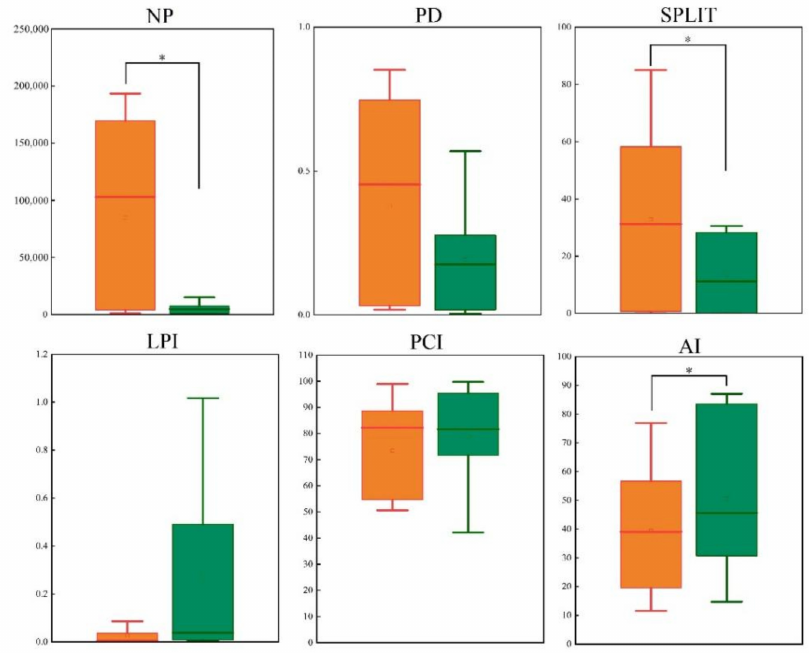
Figure 5. Comparison of potentially suitable habitats of nature reserves (Green) and non-nature (Orange) reserves of C. amherstiae. *: p <